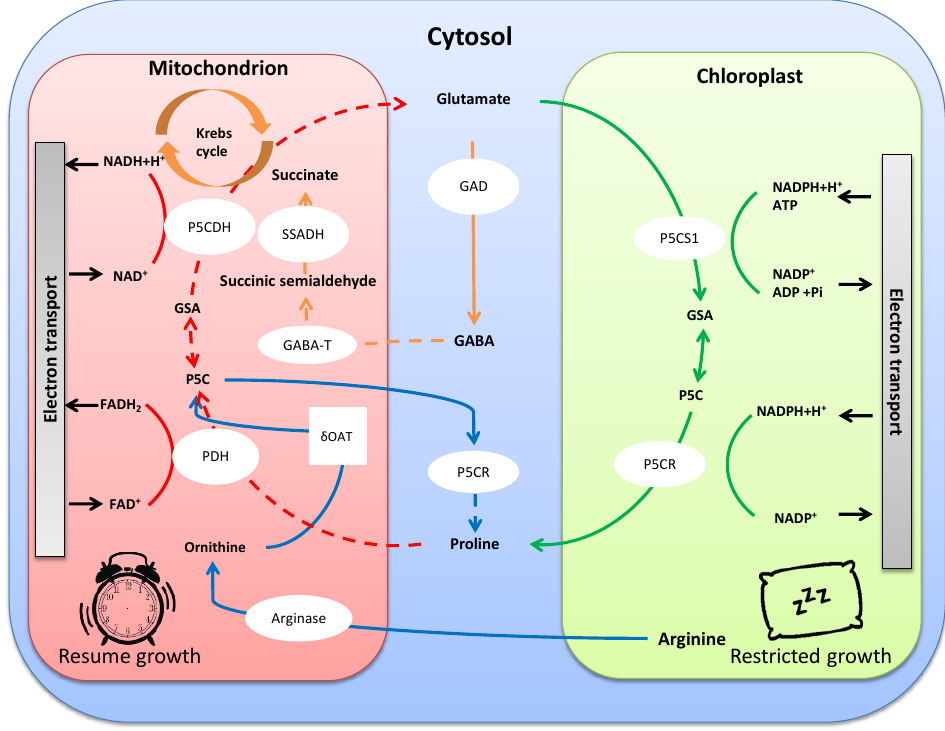
Figure 3. Importance of amino acid anabolism under stress (continuous arrows) to keep the NADPH:NADP + ratio low in the photosynthetic chain, preventing photoinhibition. Amino-acid catabolism (dashed arrows) provides energy for plant growth to resume.